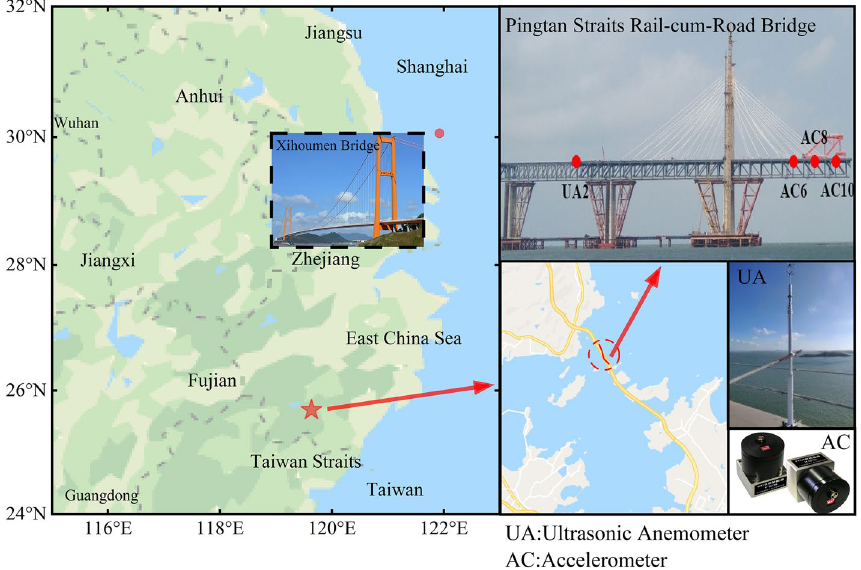
Fig. 1 Locations of two investigated bridges and observation points on